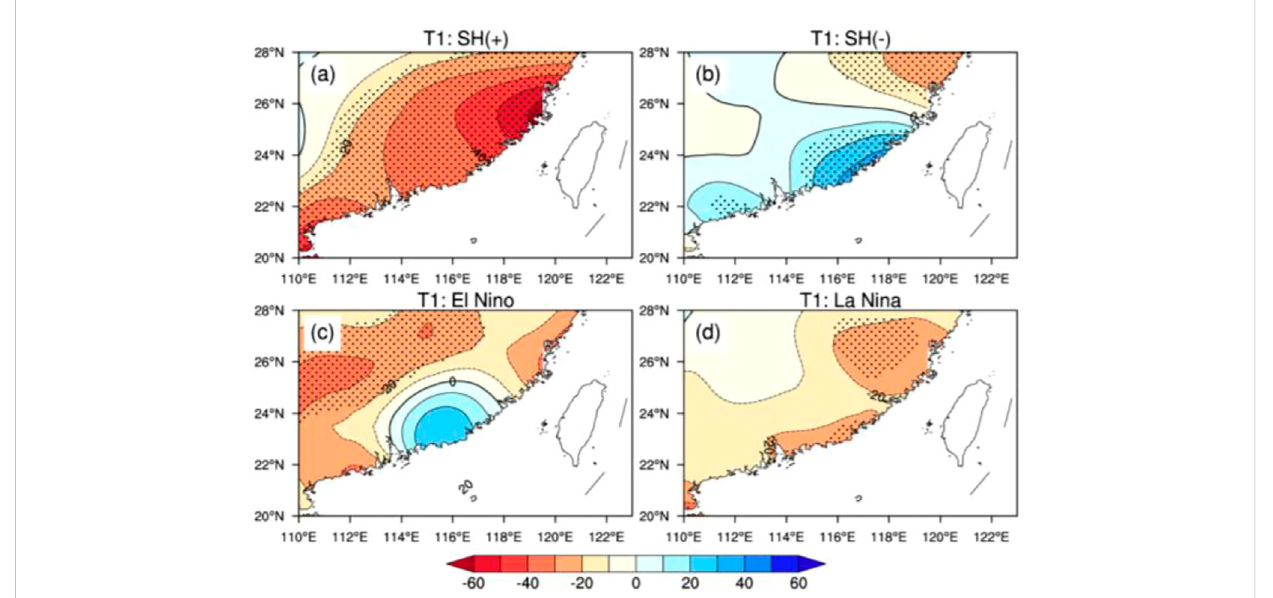
FIGURE 9 Composition of midsummer precipitation anomalies in South China in different phase years of the spring SH ( (A,B) represent years of positive and negative SH, respectively) and the Ni – o-3 index anomalies ( (C,D) represent years of El Niño and La Niña, respectively) under positive PDO phases during 1979 – 2019 (unit: mm; the dotted areas passing the 90% signi fi cance level test).